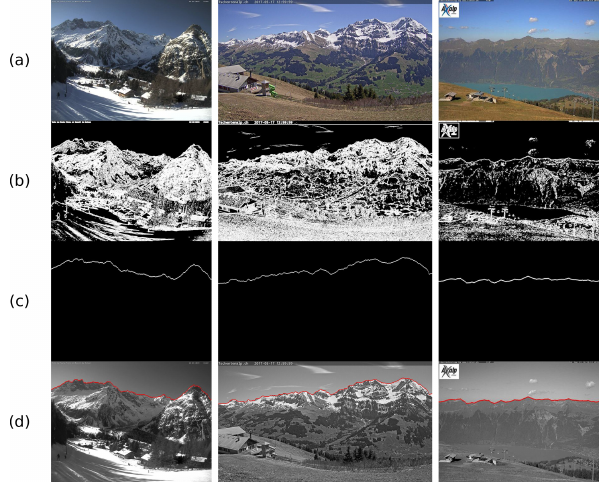
Figure 4. Three examples of automatic silhouette extraction. (a) Webcam images, (b) extracted edges using Sobel edge detec- tion, (c) detected mountain silhouettes, and (d) mountain silhou- ettes (red) superimposed on grayscale webcam images. Webcam images (left to right): La Fouly (© Pays du St. Bernard, #lafouy, #mypsb), Tschentenalp (© Verein Trainingszentrum Adelboden, https://www.adelboden.ch/de/s/home, last access: 23 March 2020), and Axalp (© Sportbahnen Axalp Windegg AG, 3855 Axalp).